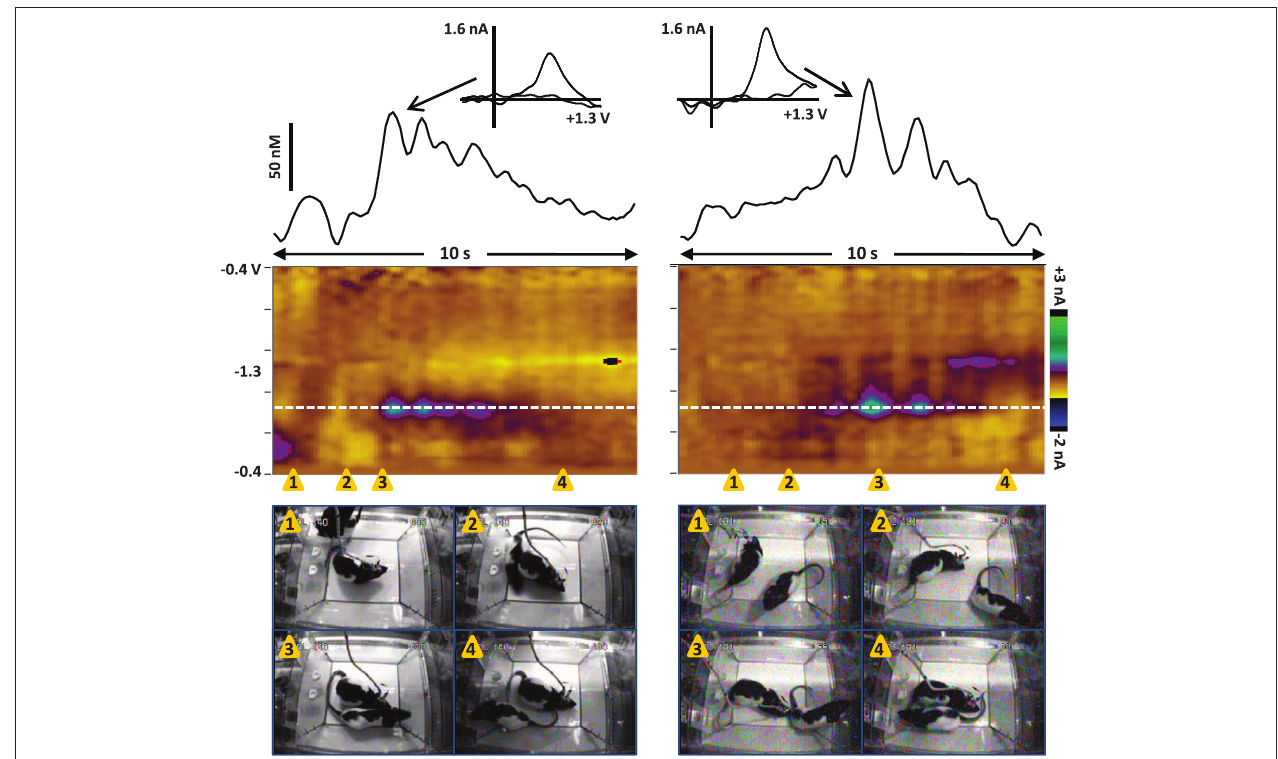
Figure 2 | Dopamine transients in the NAc core of male rats during brief interaction with another male. Left: Dopamine release is associated with initial whisker contact and sniffing of the peer. Right: Dopamine transients in a different rat occur during anogenital sniffing. The color plot shows the changes in current at each applied potential over a 10-s window, and current at the oxidation potential of dopamine (white dotted line) is depicted in the line trace above the color plot. The transients are confirmed to be dopaminergic by evaluation of the cyclic voltammograms (inset above). Snapshots from the video record of the